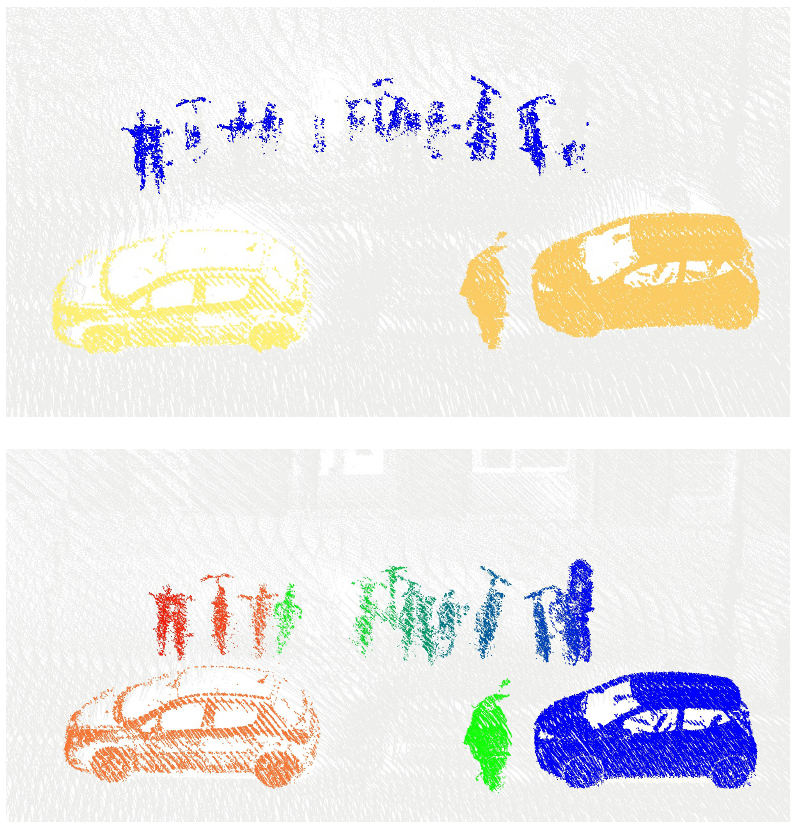
Figure 9. Top , vehicle instances from our proposed baseline using BEV projections and geometrical features in S 3 Paris data. Bottom , ground